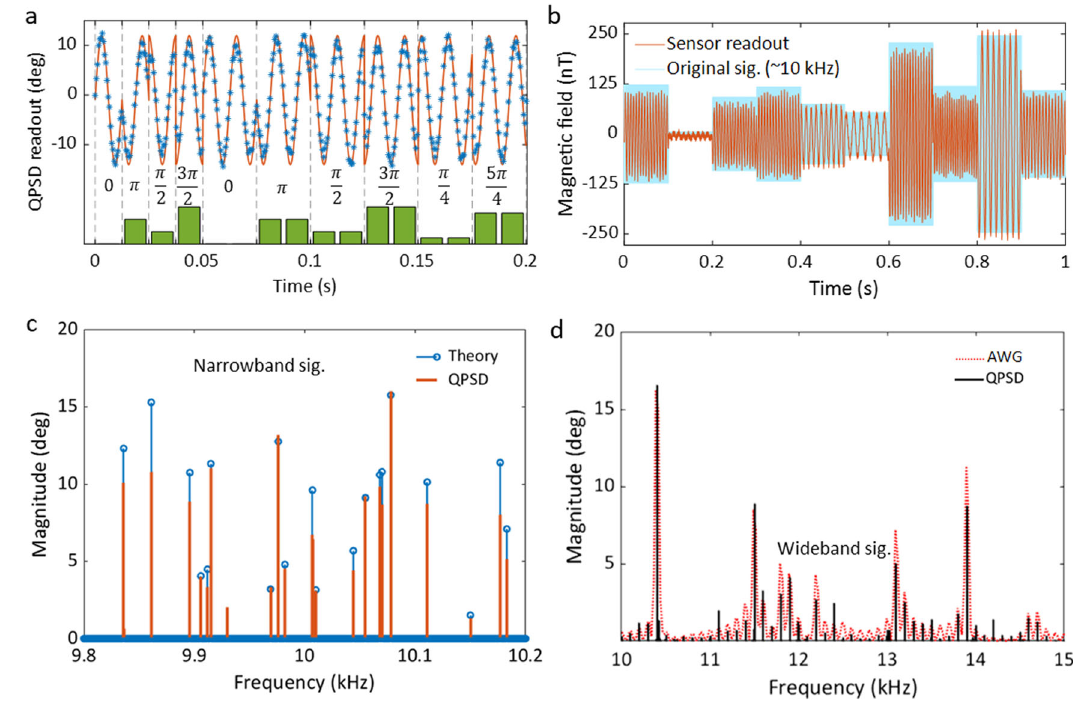
Fig. 4 | Detection of arbitrary audio signals. a Phase response of the QPSD measurement. The bars show the phases dynamics of the applied magnetic fi eld. StarsmarktheQPSDreadoutofthesensor,andthecurveisthesimulatedreadout. b QPSD readout of an ac fi eld around 10kHz with the frequency, amplitude and phase switched every 100ms. The waveform of the applied fi eld is plotted in light blue, and the red curve is the QPSD heterodyne readout. c Spectral comparison of